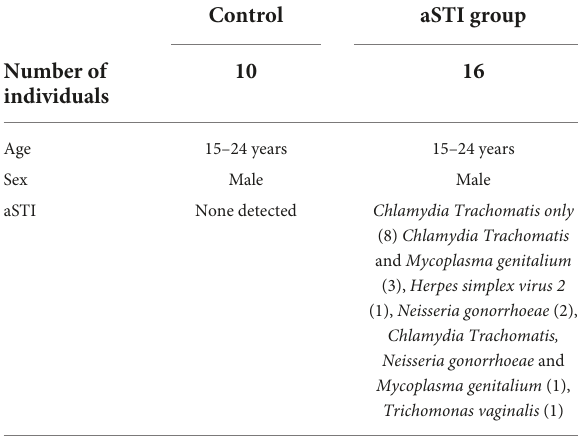
TABLE 1 Description of the number of samples used for proteomic